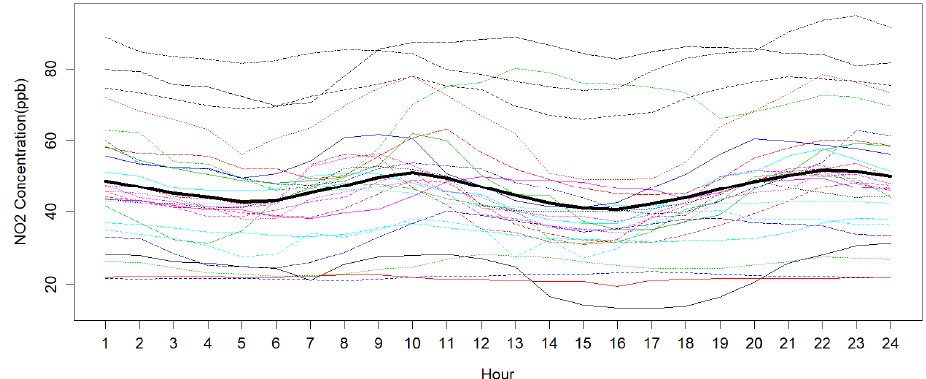
Figure 2. The smoothed diurnal curves of the NO (cid:2870) concentrations in 26 training monitoring stations (light lines) and their means (dark line). (light lines) and their means (dark line).